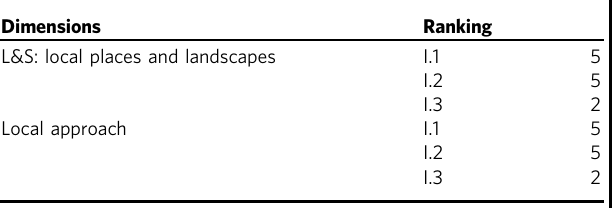
Authors ’ own work.